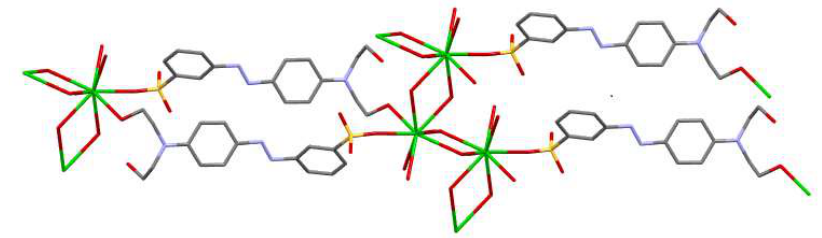
Figure 8. Part of the 2-dimensional coordination polymer structure of [Ba( 17* )(OH 2 ) 5 ]. Propagation of the polymer is through Ba-O-Ba bridges parallel to the a direction and through head and tail bonding of the azo ligand parallel to the bc diagonal. H atoms are omitted for clarity. Green = Ba.